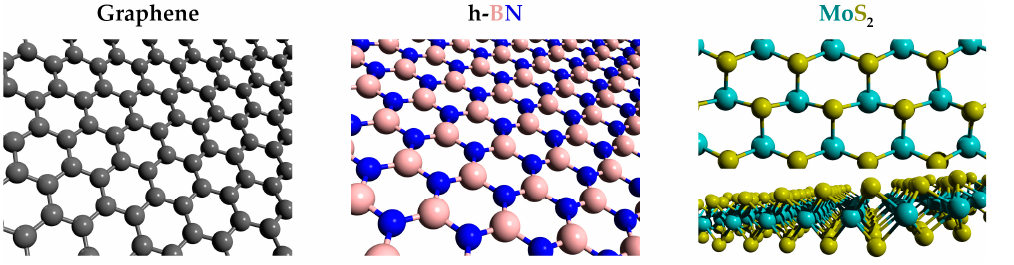
Figure 2. The crystalline structure of graphene, h-BN, and MoS 2 monolayers. The structure of other TMDs is the same as MoS 2 .